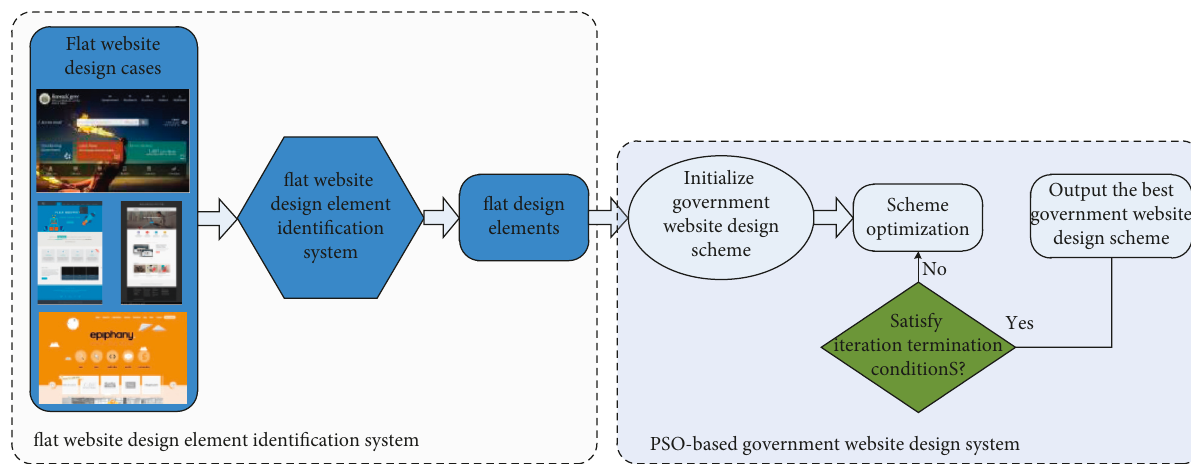
Figure 1: Schematic diagram of the established government website design